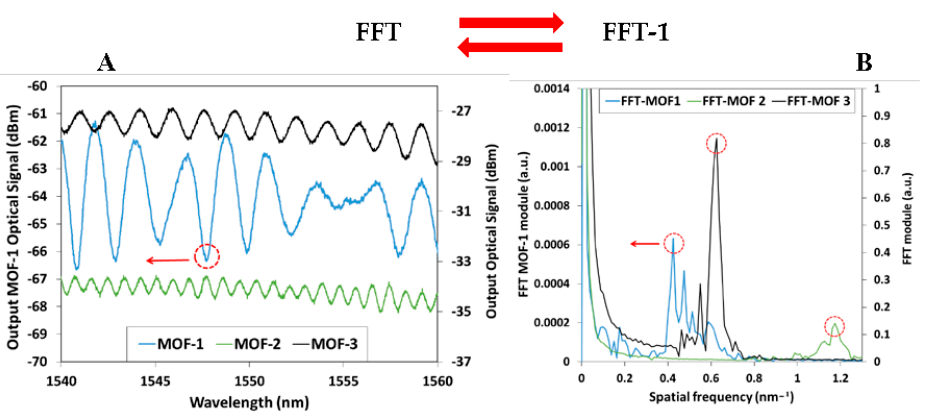
Figure 3. ( A ) Optical spectrum of MOFs and their FFTs ( B ); in both figures, the vertical left axel is applied for MOF-1 and the right axel for MOF-2 and MOF-3.